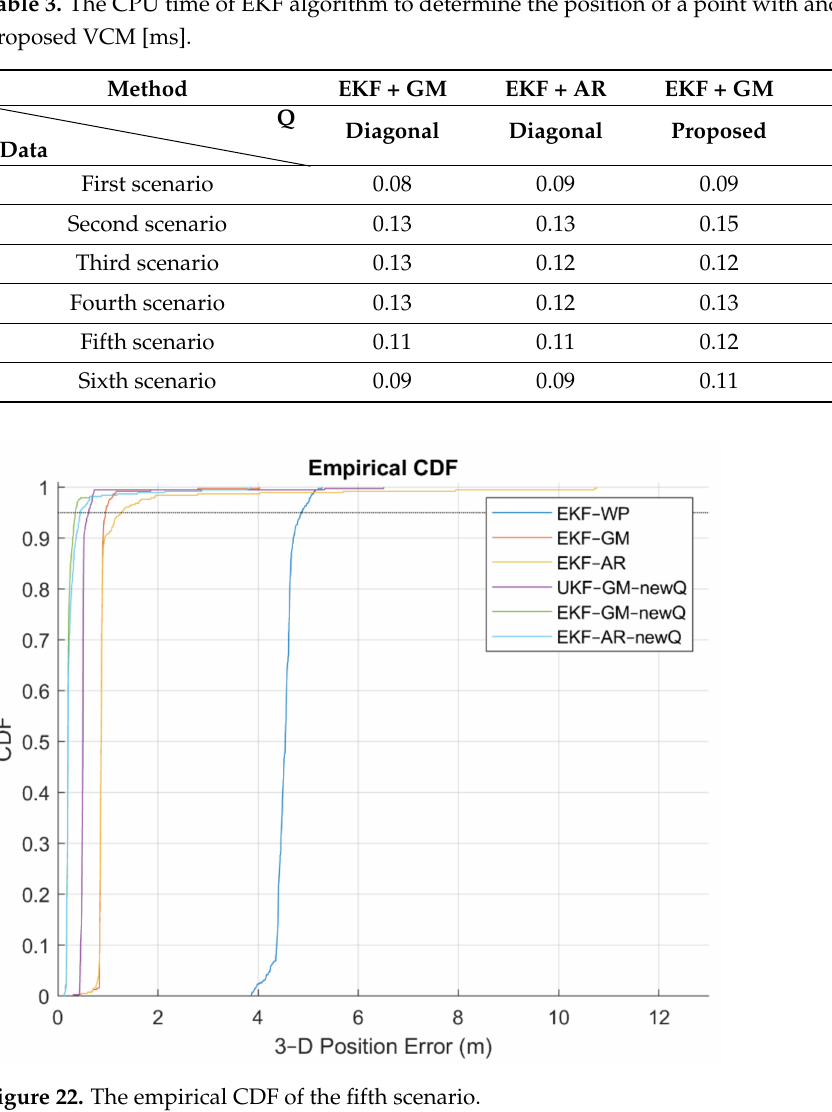
Figure 22. The empirical CDF of the fifth